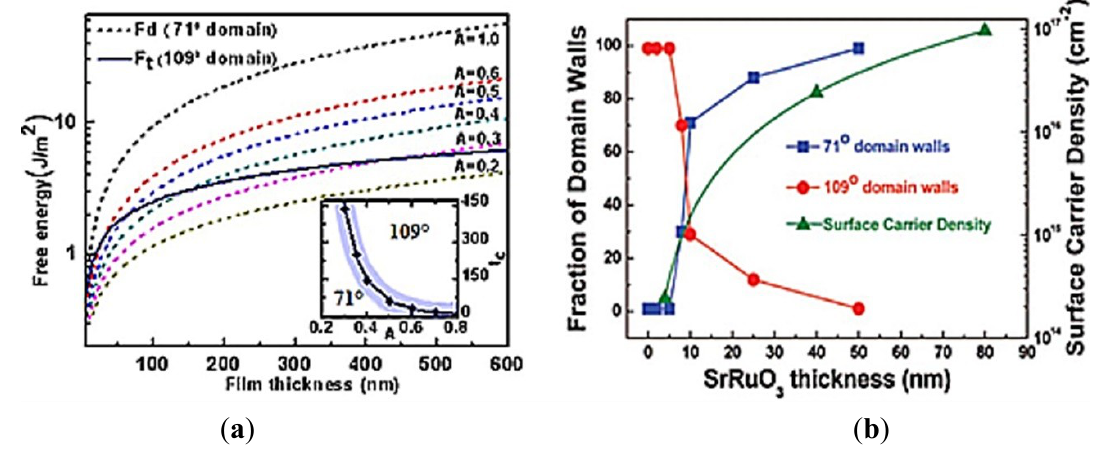
Figure 11. Effect of depolarization field on stability of 71° and 109° domains in BFO thin films. ( a ) Theoretical prediction of critical thickness t ( b ) Experimental evolutions of domain of La-BiFeO thickness (Reprinted with permission from [89,90]. Copyright 2011 American Institute